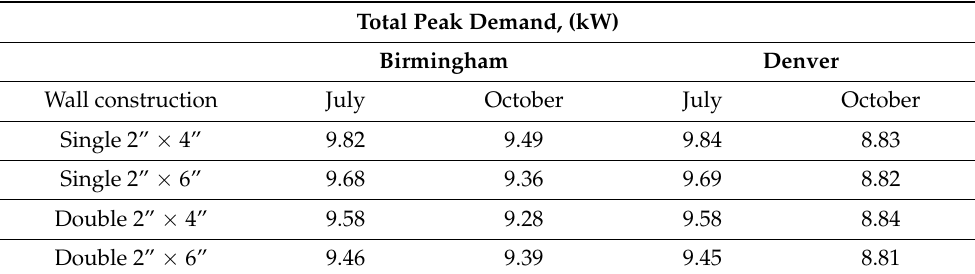
Table 9. Total household peak demand by different wall